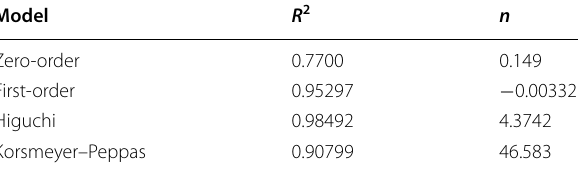
Table 6 Drug release kinetics data of Pemigatinib SSNEDDS